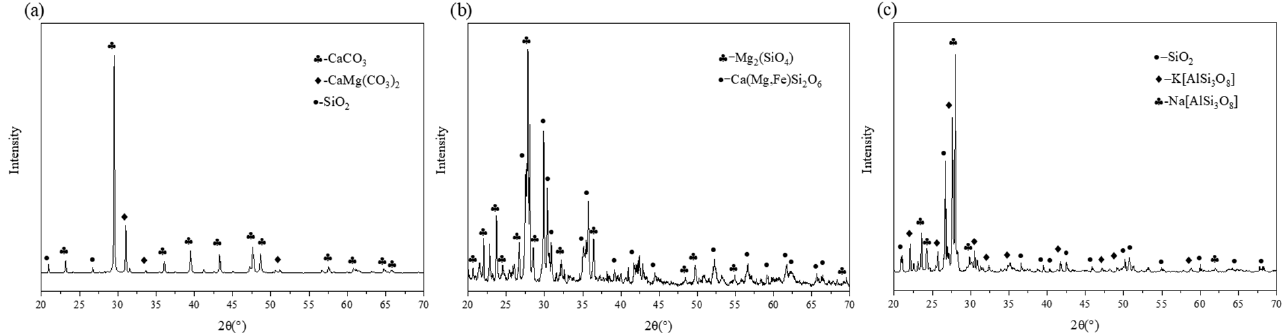
Figure 1. XRD diffractions of mineral fillers: ( a ) limestone powder; ( b ) basalt powder; ( c ) granite powder.